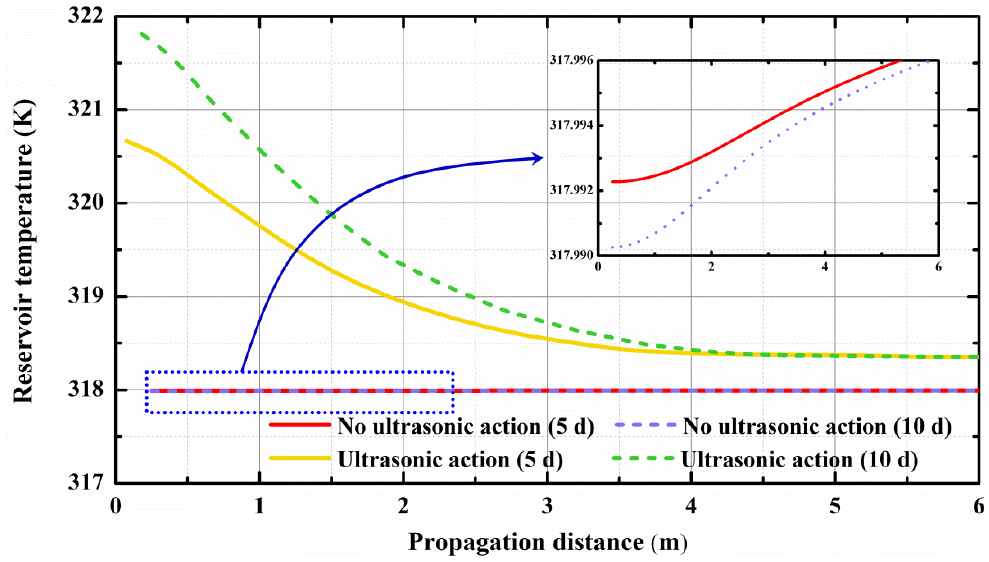
Figure 6. Simulation results of reservoir temperature changes without and with ultrasonic waves.